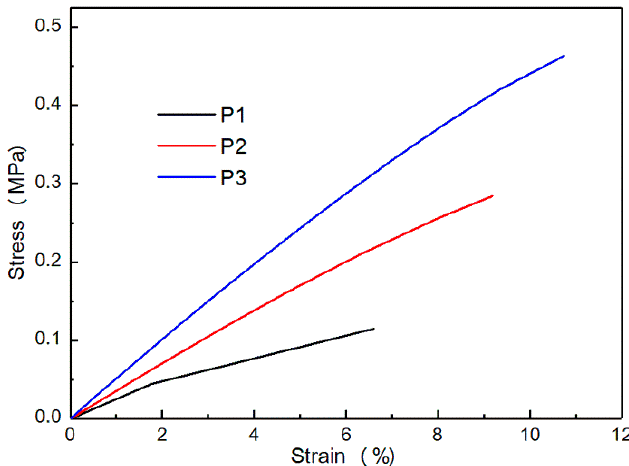
Figure 6. Stress-strain curves for the three films.